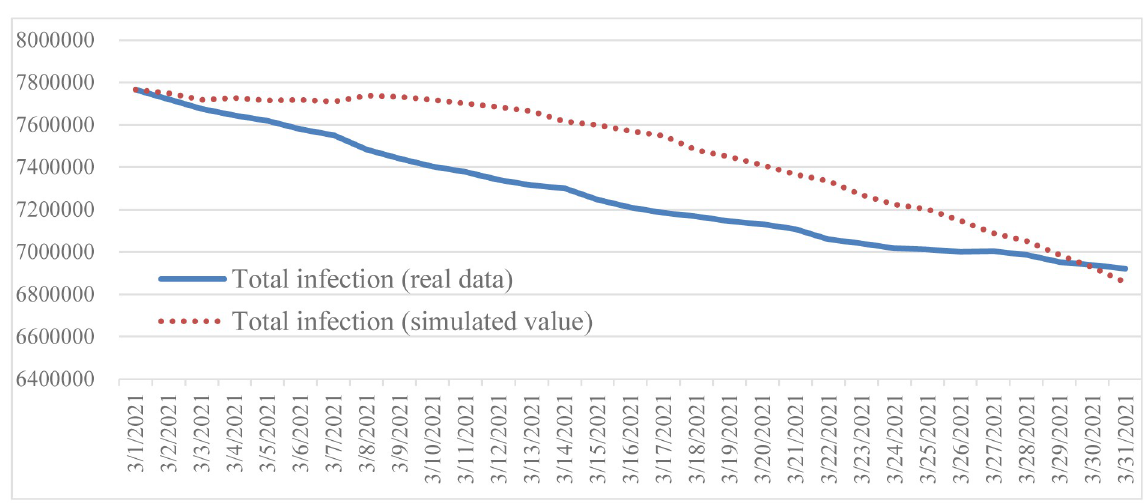
Fig 4. Comparison of reported total infection and simulated total infection.